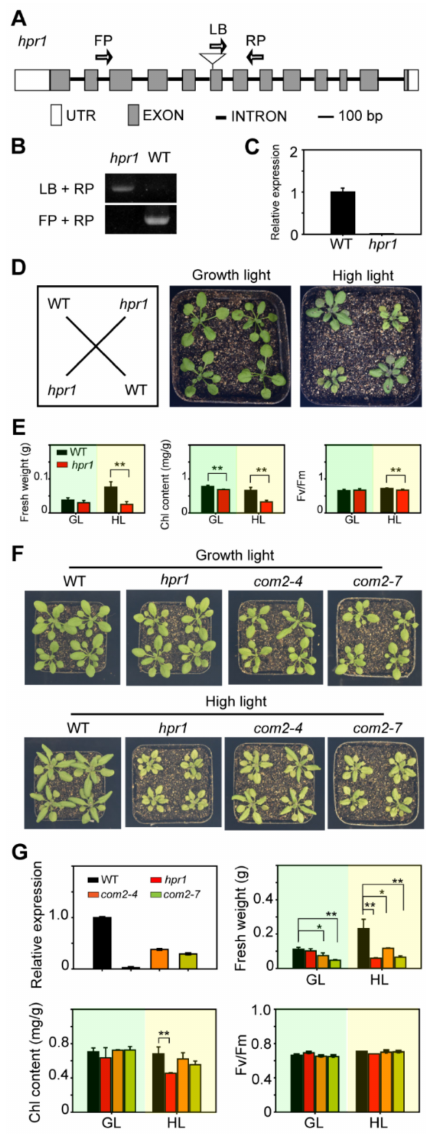
Figure 2. Identification of hpr1 . ( A ) Genomic structure model of HPR1 . Gray rectangles show the open reading frame, the black line shows intron, white rectangles show untranslated regions, and the triangle represents T-DNA insertion. ( B ) PCR analysis of genomic DNA from the WT and hpr1 plants. LB, RP and FP indicate primers which locations are shown in ( A ). ( C ) The expression of HPR1 in WT and hpr1 plants was analyzed by qRT-PCR. ( D ) Phenotypes of four-week-old WT and hpr1 mutants. We transferred three-week-old plants grown in soil to growth light (GL, 80 µ mol · m − 2 · s − 1 ) and high light (HL, 350 µ mol · m − 2 · s − 1 ) for another week, respectively. ( E ) Fresh weight (left), chlorophyll content (middle), and chlorophyll fluorescence (right) of WT and hpr1 plants grown in soil. They were treated with the same light intensity in ( D ), respectively. Data shown are means ± SD, n = 3, with three independent replicates. Asterisks show significant differences compared to WT: ** p < 0.01 (Student’s t test). ( F ) Molecular complementation assay by expressing full length CDS of HPR1 in the hpr1 mutants. WT, hpr1 , and two complementary lines treated by growth light with 80 µ mol · m − 2 · s − 1 and high light intensity with 350 µ mol · m − 2 · s − 1 for one week. ( G ) The HPR1 gene expression level, fresh weight, chlorophyll content and chlorophyll fluorescence of WT, hpr1 , and two complementary lines grown under growth light (GL, 80 µ mol · m − 2 · s − 1 ) and high light intensity (HL, 350 µ mol · m − 2 · s − 1 ). Data shown are means ± SD, n = 3, with three independent replicates. Asterisks show significant differences compared to WT: * p < 0.05; ** p < 0.01 (Student’s t